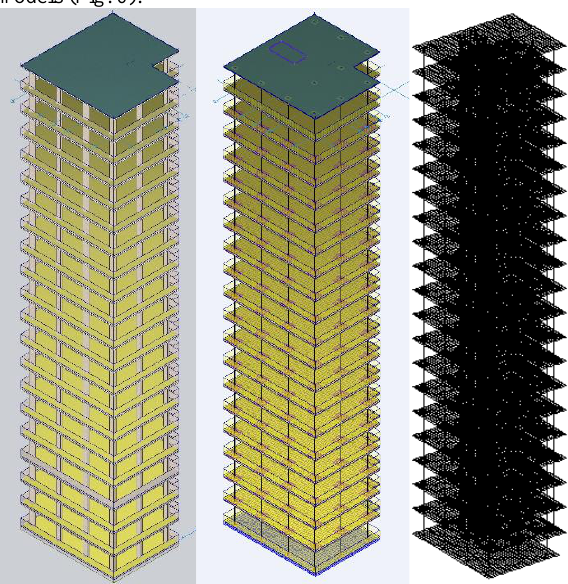
Figure 6 . Various models are drawn from BIM: analytical, calculation, and meshed.